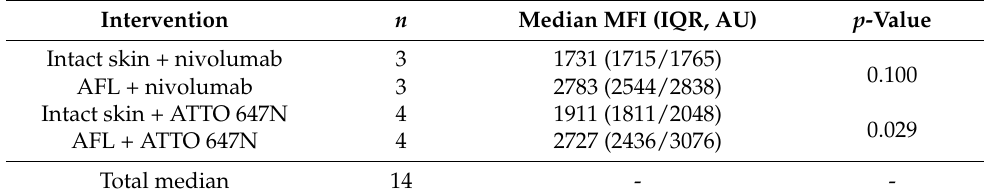
Table 1. Fluorescence intensity. Intervention n Median MFI (IQR, AU) Intact skin +